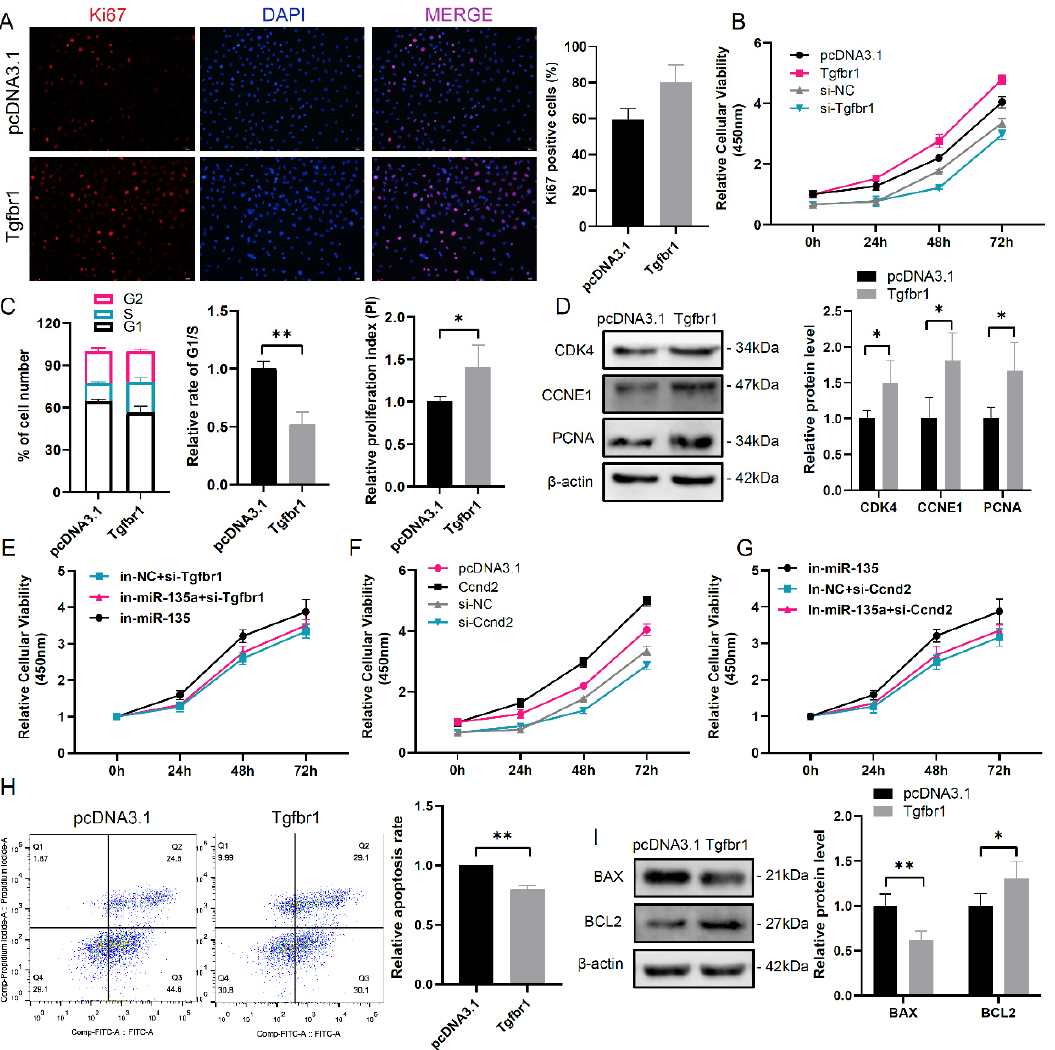
Figure 3. miR-135a affects mGC proliferation via regulating Tgfbr1 expression. ( A ) Immunofluorescence staining of cell proliferation marker Ki67 in Tgfbr1 overexpressed mGCs. The nuclei were stained by DAPI (blue). Scale bar: 50 μ m. The quantification of the Ki67-positive cells in right panel. ( B ) Cell viability was detected by CCK-8 assay in Tgfbr1 overexpressed or inhibited mGCs. ( C ) The cell cycle was detected by flow cytometry assay in Tgfbr1 overexpressed mGCs. ( D ) Western blot analysis of cell cycle and proliferation-related protein levels in Tgfbr1 overexpressed mGCs. ( E – G ) Cell viability was detected by CCK-8 assay with indicated treatment in mGCs. ( H ) The apoptosis assessment was measured using Annexin V-FITC/PI and flow cytometry in Tgfbr1 overexpressed mGCs. ( I ) Western blot analysis of apoptosis-related protein level in Tgfbr1 overexpressed mGCs. The means ± SD were calculated from three independent experiments. * p < 0.05, ** p < 0.01.